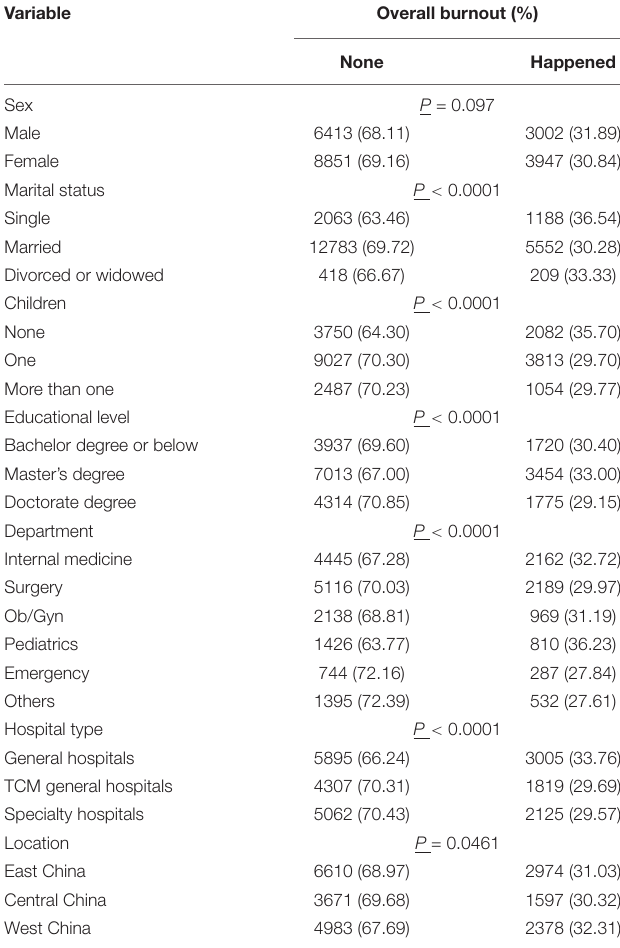
TABLE 2 | Distribution of